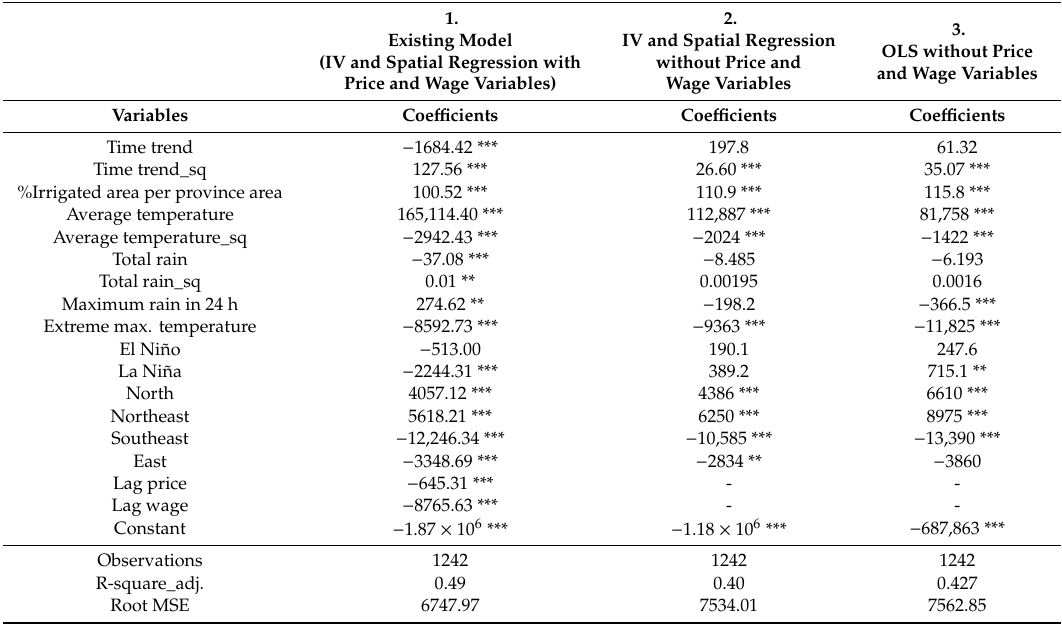
Table A2. Comparison of yield models with and without price and wage variables.